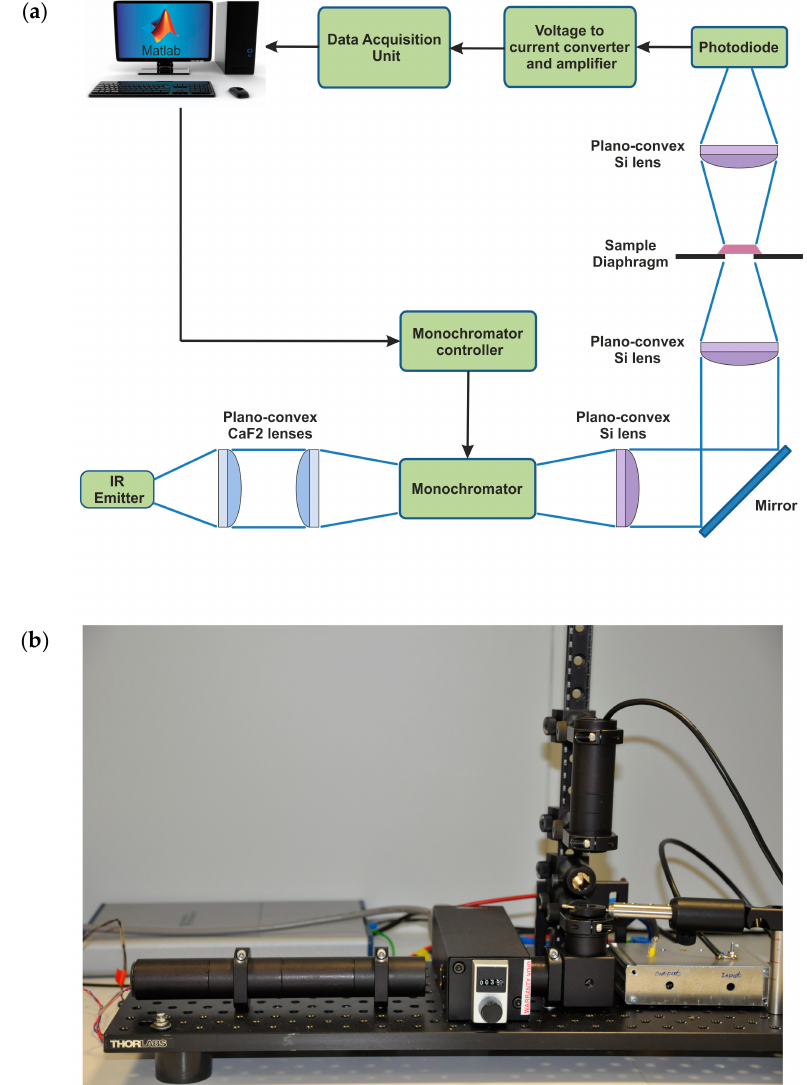
Figure 2. ( a ) Schematic of the overall IR instrument setup. The system includes a thermal emitter as infrared light source, a monochromator for light filtering, an optical lens system to guide the light, and a photodiode for signal detection. The light beam is collimated and focused into the entrance of the monochromator by plano-convex CaF 2 lenses (f = 75 mm). After the monochromator, the light is collimated by a Si plano-convex lens (f = 25 mm) and vertically directed by an IR mirror. A second Si plano-convex lens focuses the light beam into the sample holder where the specimen is placed for IR analysis. The light transmitted by the sample is collected by a third Si plano-convex lens and focused onto the active area of the photodiode; ( b ) Photo of the IR sensor system.